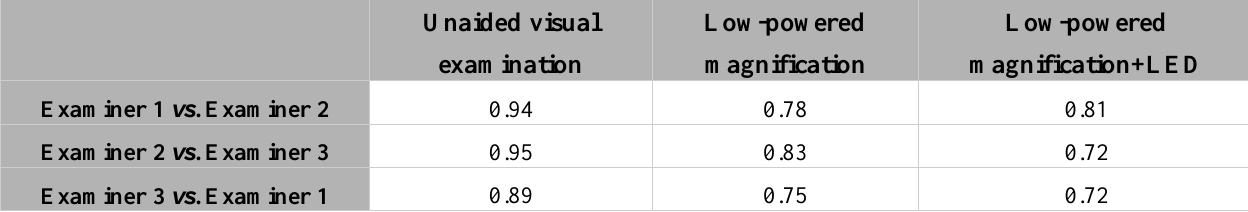
Table 5. Interexaminer reproducibility of ICDAS examinations (Weighted Kappa) for Primary molars.